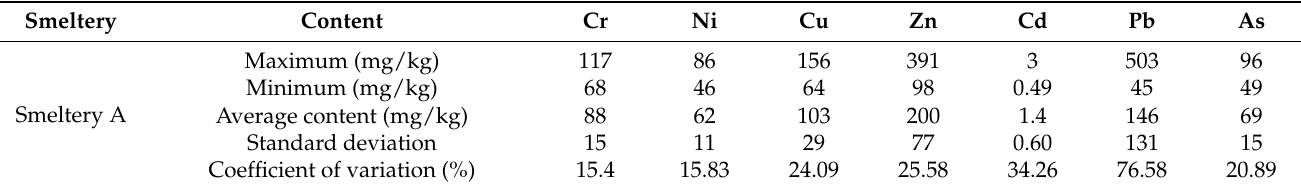
Table 2. Contents of seven toxic elements in tested soil